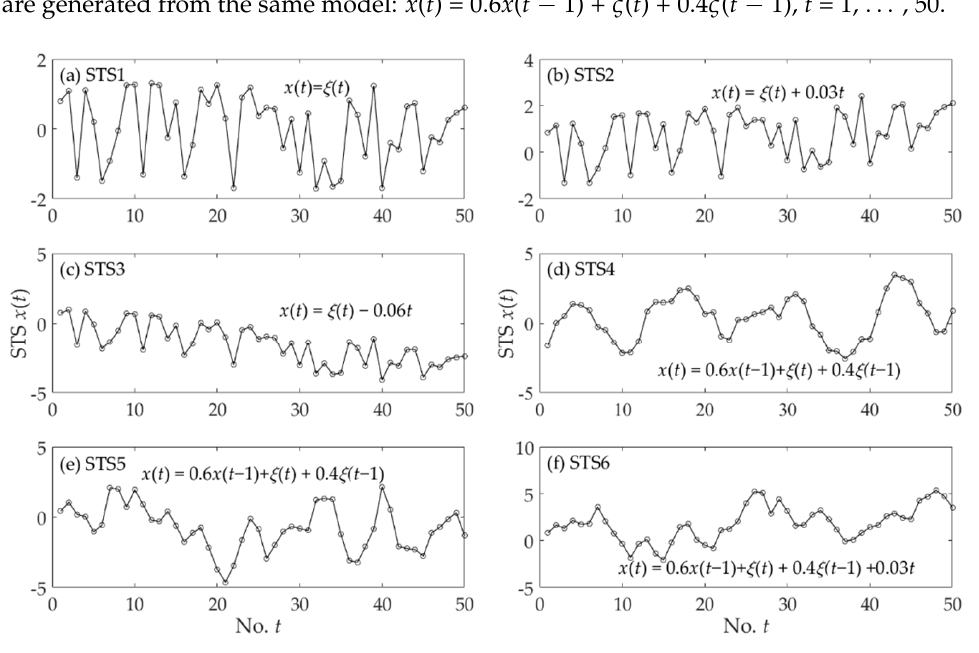
Figure 6. Six STSs generated by Equation (15). (Note: ξ ( t ) follows the standard normal distribu-